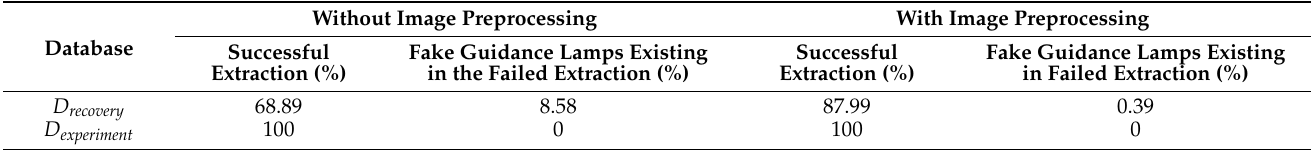
Table 3. Results of guidance features for datasets D recovery and D experiment .